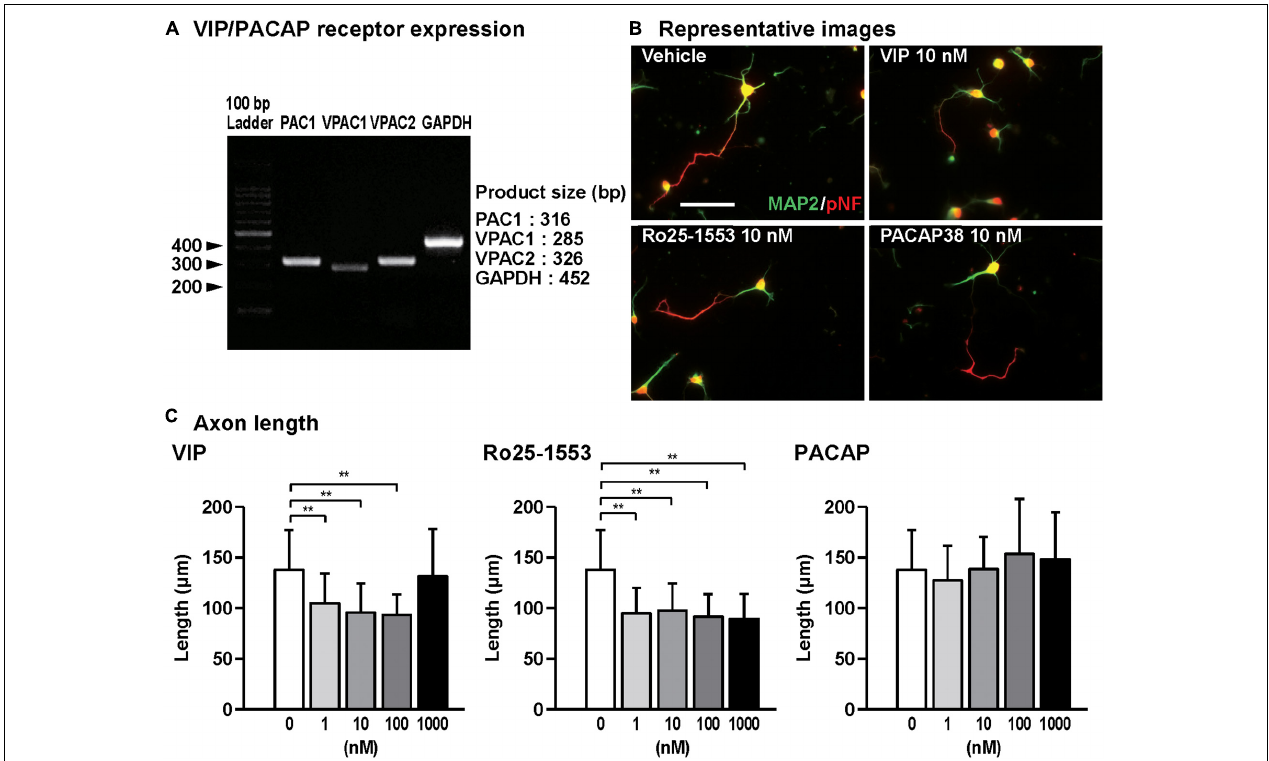
FIGURE 1 | Effects of Ro25-1553, VIP, and PACAP on axon outgrowth in cultured cortical neurons. (A) RT-PCR analysis showed that all VIP/PACAP receptors PAC1, VPAC1, and VPAC2 were expressed in primary cultured cortical neurons. (B) Representative pNF- and MAP2-immunostained images of cultured cortical neurons are shown. Cells were cultured with Ro25-1553 (10 nM), VIP (10 nM), or PACAP38 (10 nM) for 3 days in vitro and double-immunostained for pNF (red) and MAP2 (green). Scale bar, 50 µ m. (C) Quantitative analysis of changes in axon length was shown. VIP ( F 4 , 215 = 16.542, P < 0.0001) and Ro25-1553 ( F 4 , 215 = 25.257, P < 0.0001), but not PACAP ( F 4 , 215 = 2.383, P > 0.05), reduced the axon length. Values represent mean ± SD of 40–60 neurons from three independent experiments. ** P < 0.01 vs.